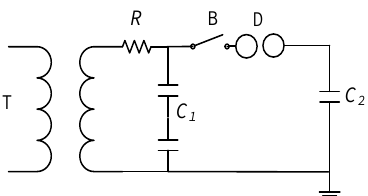
Figure 3. Schematic diagram of test circuit.